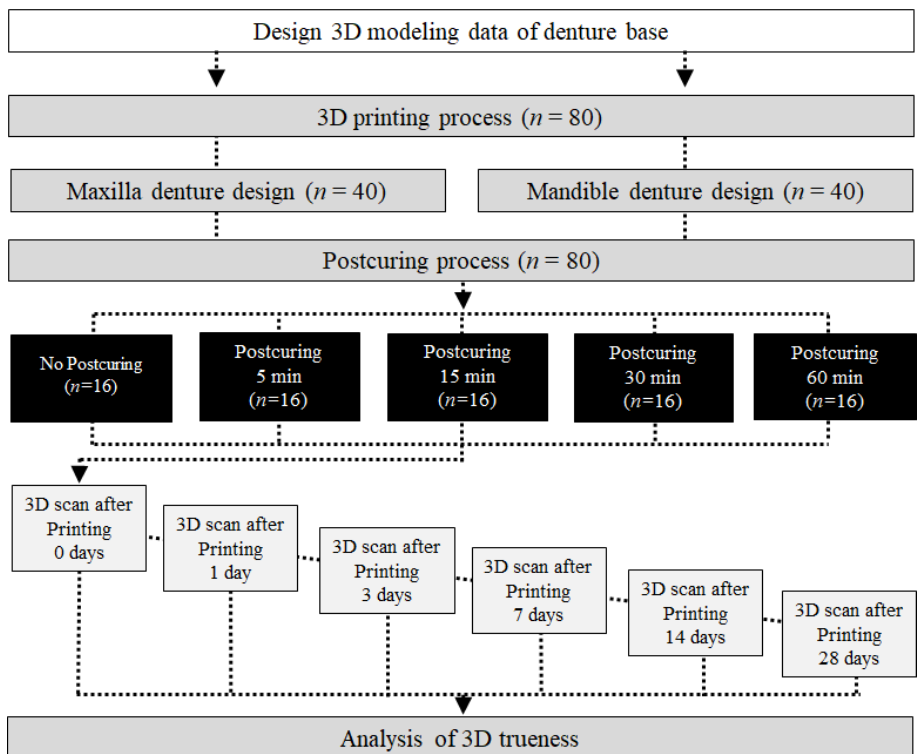
Figure 1. Flowchart of the study design. n = number of specimens.